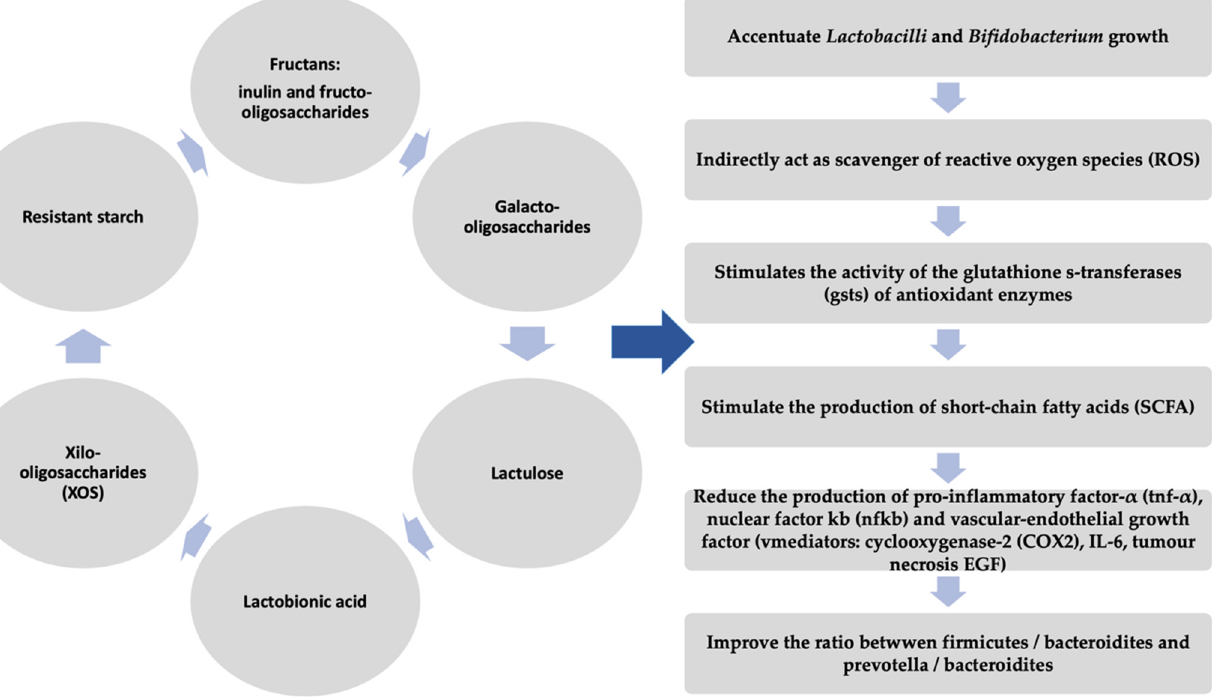
Figure 3. Beneficial effects of prebiotics.